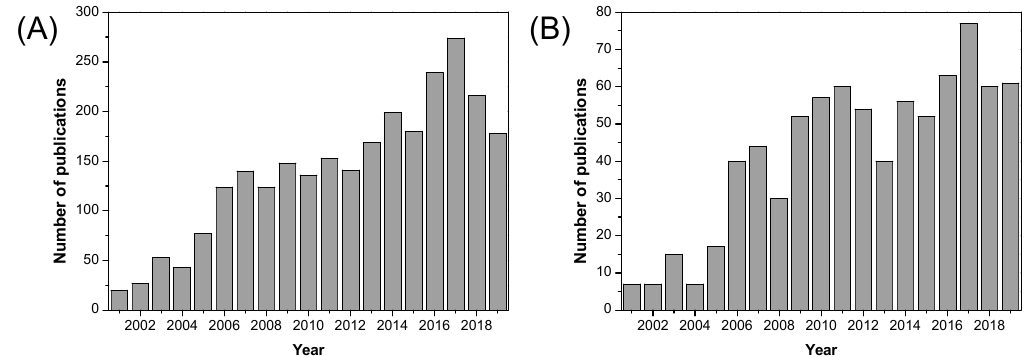
Figure 22. Number of publications in the period of 2001–2019 indexed in the Web of Science: ( A ) keywords: ionic liquid AND fuel cell; and ( B ) keywords: ionic liquid AND fuel cell AND proton exchange membrane. Source: